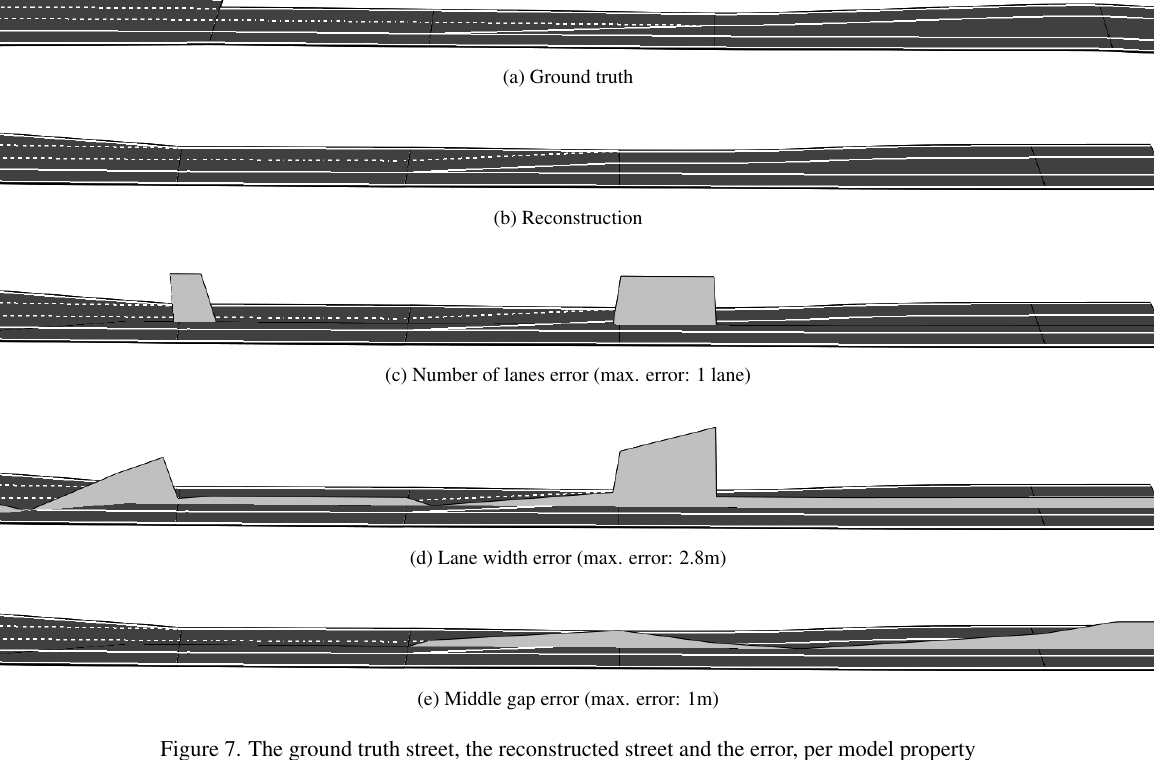
Figure 7. The ground truth street, the reconstructed street and the error, per model property